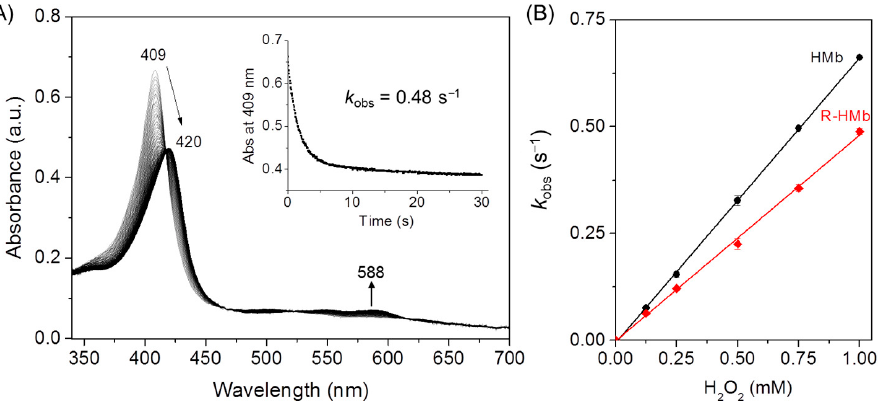
Figure 6. ( A ) The stopped-flow spectra of the ribosylated HMb (R-HMb) in reaction with H 2 O 2 (1 mM) at pH 7.0 for 30 s. Inset: The decay of the Soret band at 409 nm. ( B ) The plots of the observed rate constants versus the H 2 O 2 concentrations, with the results of the HMb shown for comparison.